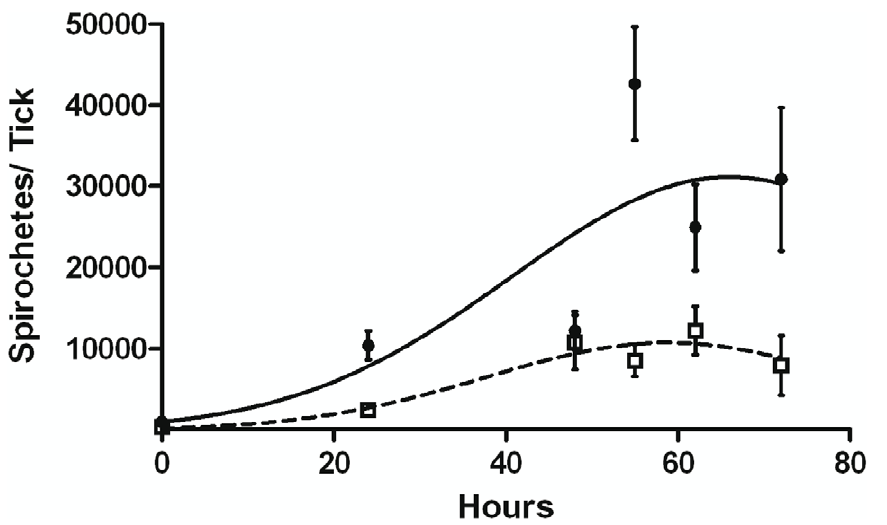
N , B31-A3; % , CP176. Spirochete densities for B31-A3 and CP176 were